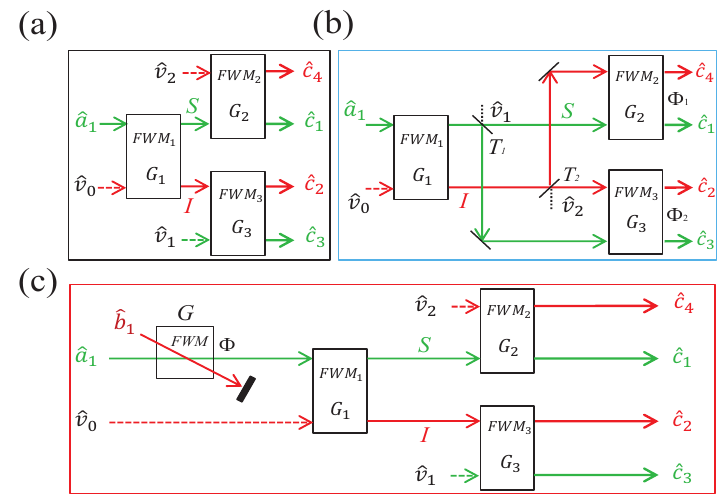
Figure 1. The schemes for the generation of four-way noiseless signal amplification from a sym- metrical cascaded FWM process ( a ), with a correlation injection scheme ( b ), and with a two-beam phase-sensitive amplifier scheme ( c ). ˆ a 1 and ˆ b 1 are the coherent input signal beam and the coherent input idler beam, respectively. ˆ ν 0 , ˆ ν 1 , and ˆ ν 2 are the vacuum inputs, and ˆ c 1 , ˆ c 2 , ˆ c 3 , and ˆ c 4 are the four output beams, respectively. S and I represent the signal and idler beams, respectively. G i ( i = 1–3) is the power gain in the individual FWM i process, and Φ 1 , Φ 2 , and Φ are the phases of the FWM 2 process, FWM 3 process, and pre-amplifier in ( c ), respectively. T 1 and T 2 are the transmission ratios for signal and idler beams, respectively, generated from the FWM 1